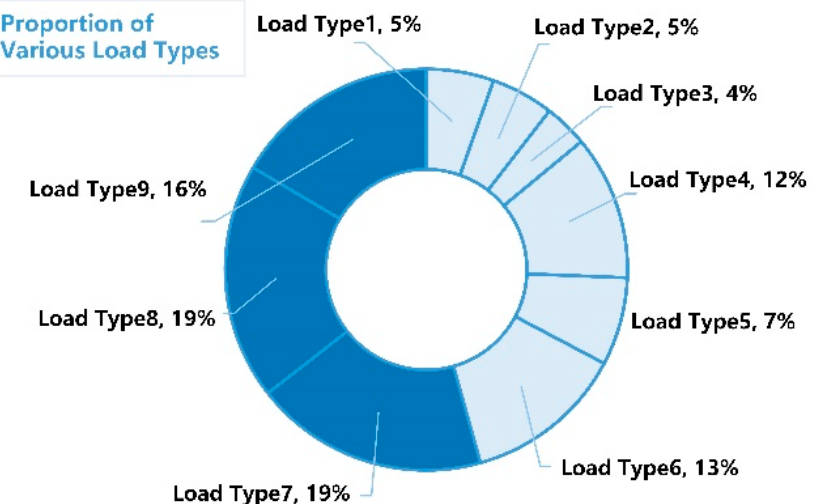
Figure 5. Proportion of each charging load type.